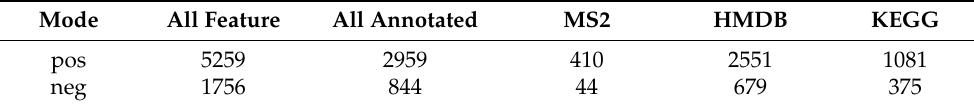
Table 1. LC-MS-based untargeted lipidomics identification results